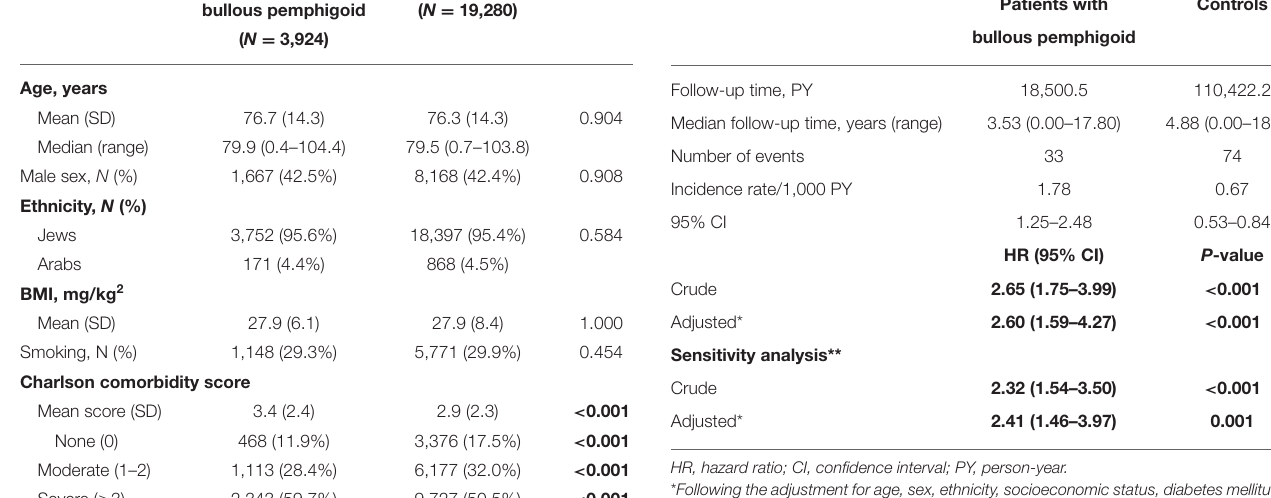
TABLE 2 | Incidence rates and hazard ratio of new-onset psoriasis among patients with bullous pemphigoid (cohort study design). Patients with